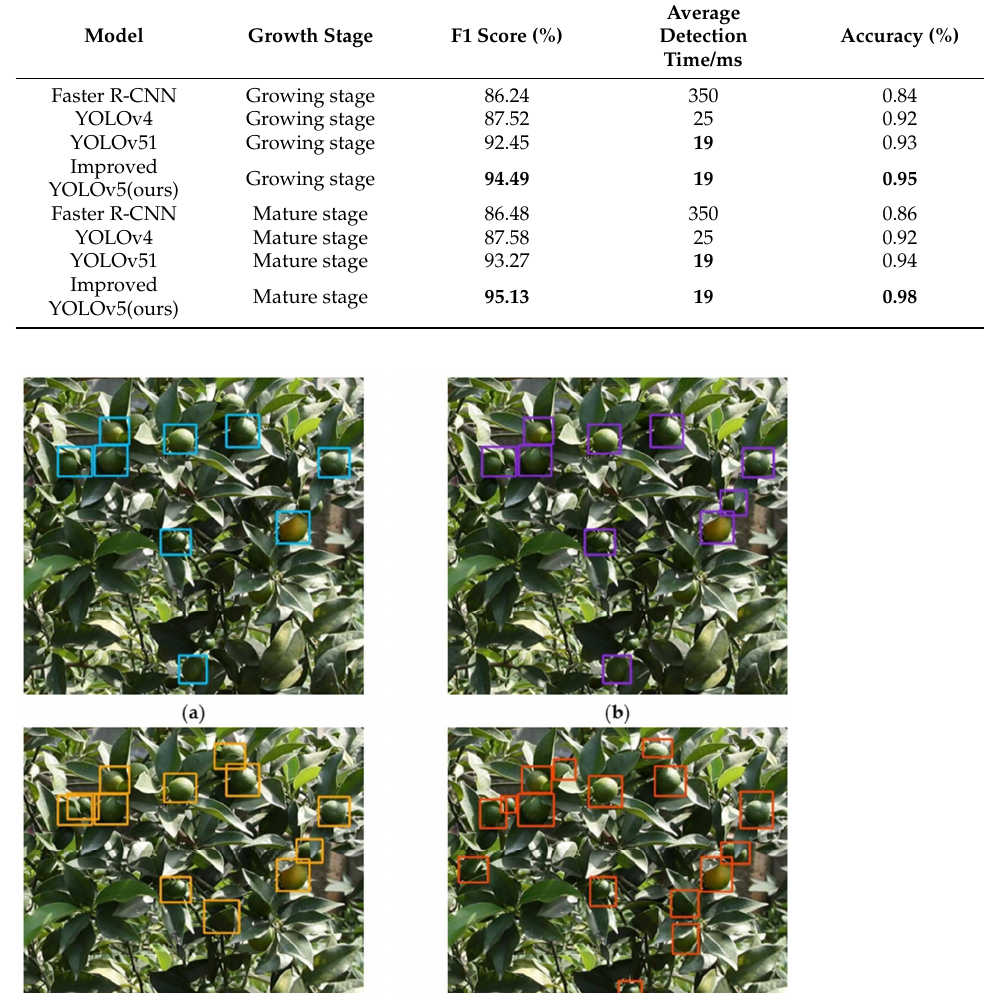
Table 5. The comparison results of four object models on the tangerine dataset at two growth stages.